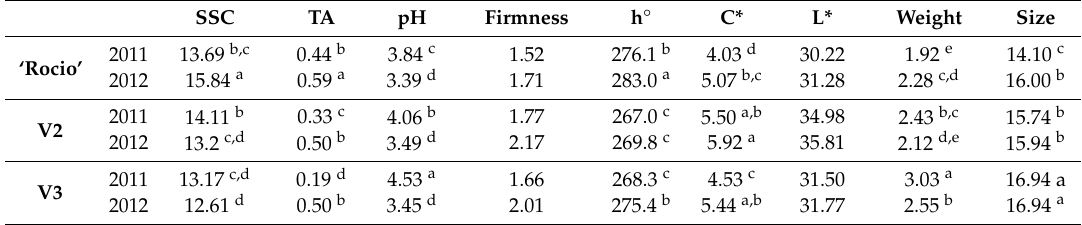
Table 4. E ff ect of genotype and sampling year on the parameters evaluated for blueberry fruits. SSC TA pH Firmness h ◦ C* L* Weight Size 2011 13.69 ‘Rocio’